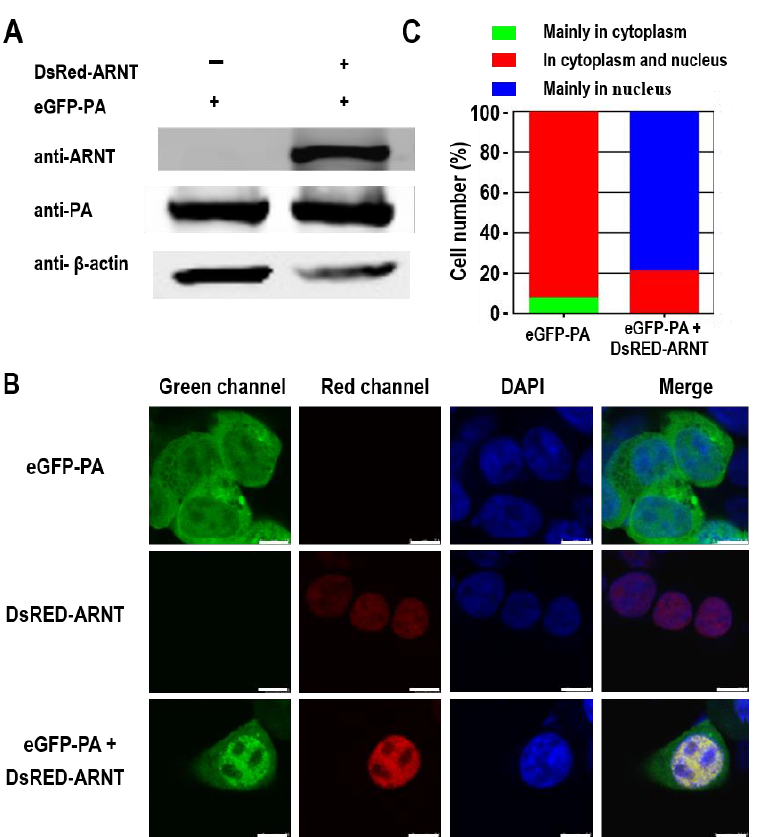
Figure 6. The effect of ARNT on the distribution of PA protein in 293T cells. ( A ) Confirmation of the expression of eGFP-PA and DsRed-ARNT in 293T cells by Western blotting. ( B ) The distribution of eGFP-PA and DsRed-ARNT in cells. 293T cells were transfected with peGFP-PA and pDsRED-ARNT individually or in combination. At 24 h p.t., the cells were fixed, and the nuclei were stained by DAPI. The cells were then scanned using a confocal microscope. Typical images are presented. ( C ) Statistical analysis of the intracellular localization patterns of PA in 293T cells. Based on the confocal microscopy data in panel A, the localization of PA was categorized into three types: clear nuclear localization (blue), simultaneous localization in the cytoplasm and nucleus (red), and predominantly cytoplasmic localization (green). The localization of PA was analyzed in more than 50 cells. The scale bar indicates 0 –7.5 μm in length.